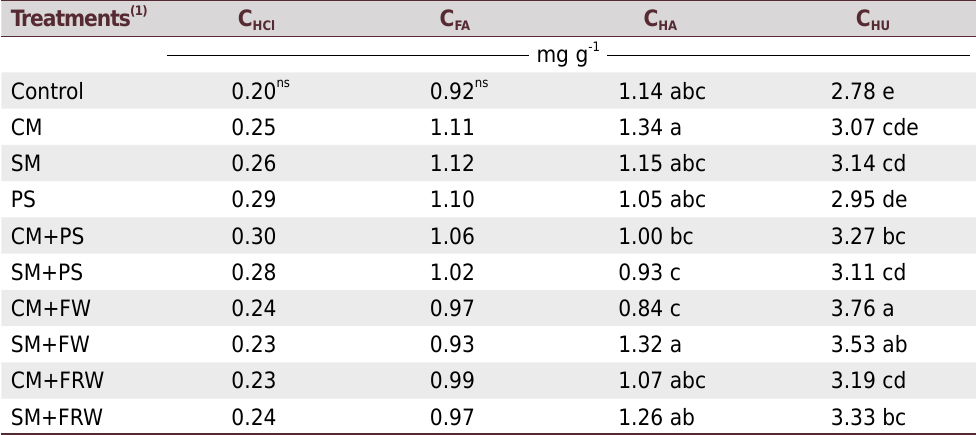
Table 4. Carbon content in the acid extract (C HCl ), as fulvic acid (C FA ), humic acid (C HA ), and humin